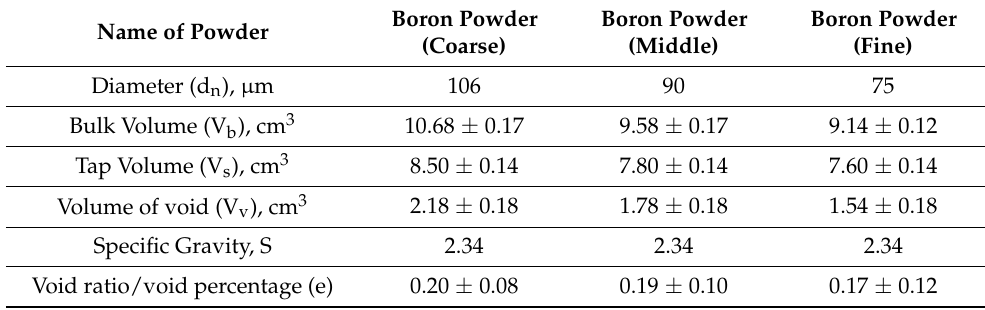
Table 4. Experimental Results.